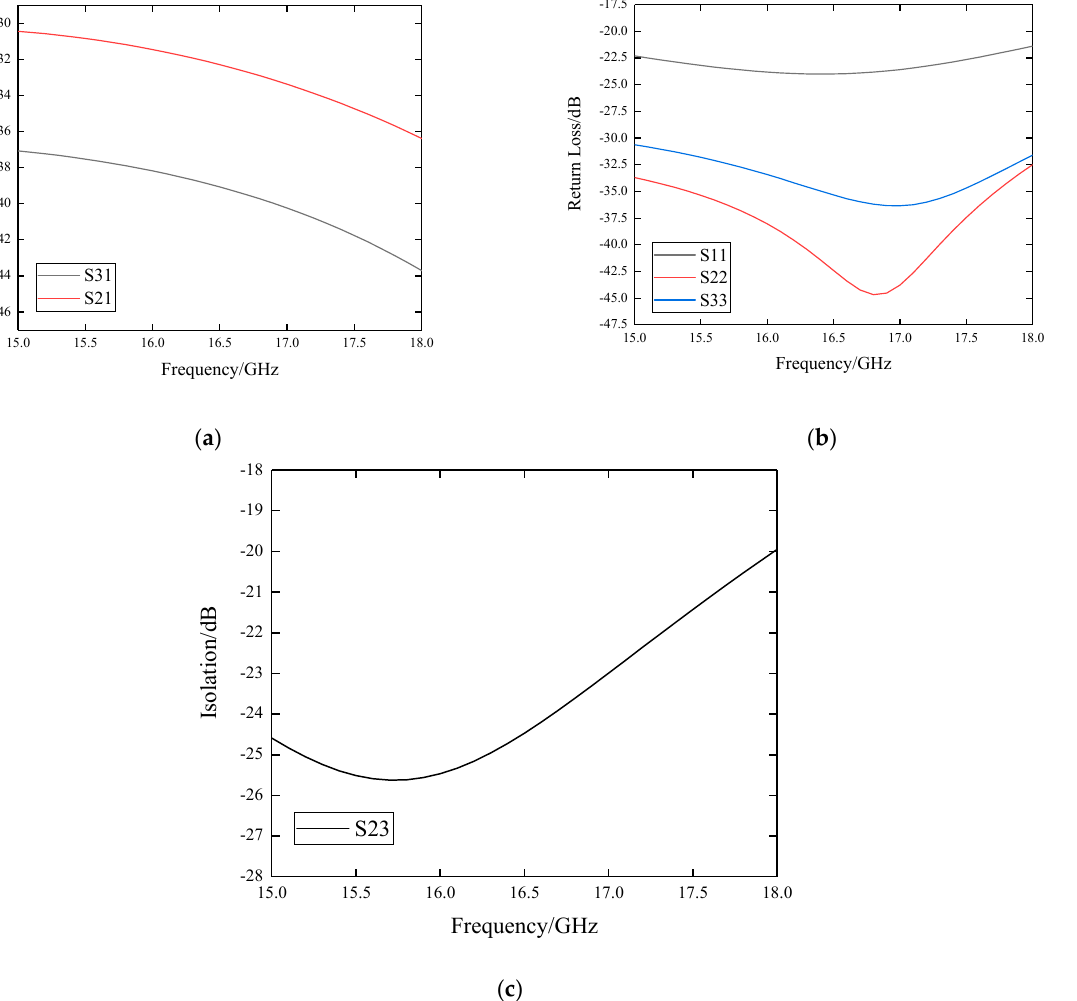
Figure 7. Simulation results of the LTCC-based stripline 2-way power divider: ( a ) insertion loss S21 and S31 ; ( b ) return loss S11, S22 and S33 ; ( c ) isolation S23 .